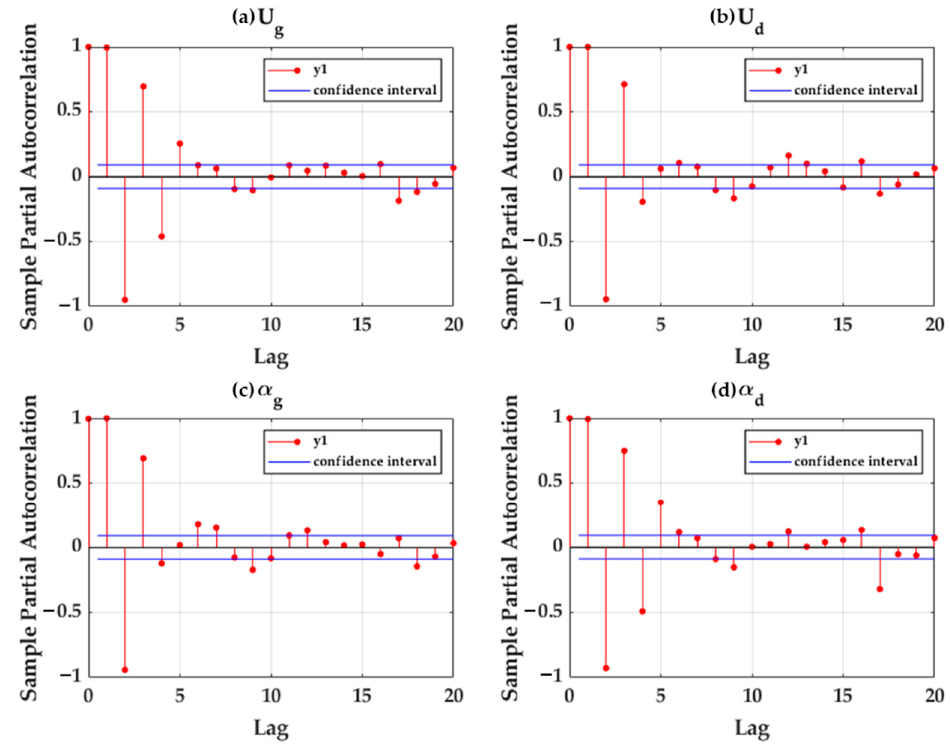
Figure 10. Partial autocorrelation function curves (PACF) of original time-series ( a ) U g ( b ) α g ( c ) U d ( d ) α d . Table 2. ADF test results.